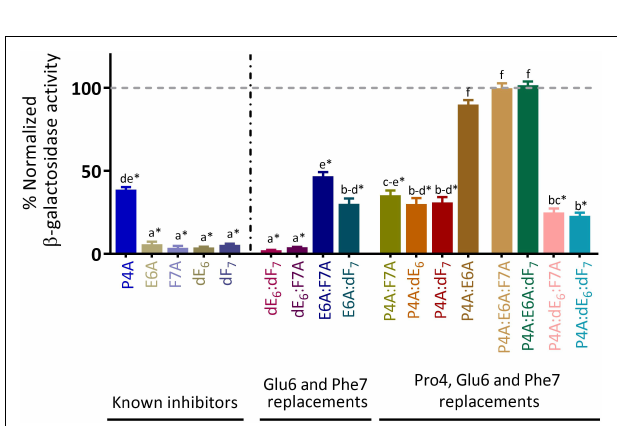
FIGURE 4 | Exploring the effect of bacterial cell density on the PapR 7 -derived peptide combinations activity. β -galactosidase activity of Bt A’Z induced by the addition of 10 µ M PapR 7 -derived peptides normalized to untreated bacterial cells at end lag phase of bacterial growth (OD 600 of 0.1 ± 0.03; mean ± SEM, n = 9). ∗ p < 0.01 indicates a statistically significant difference between untreated Bt A’Z and addition of PapR 7 -derived peptides. Different letters indicate statistically significant differences between PapR 7 -derived peptide treatments ( p <